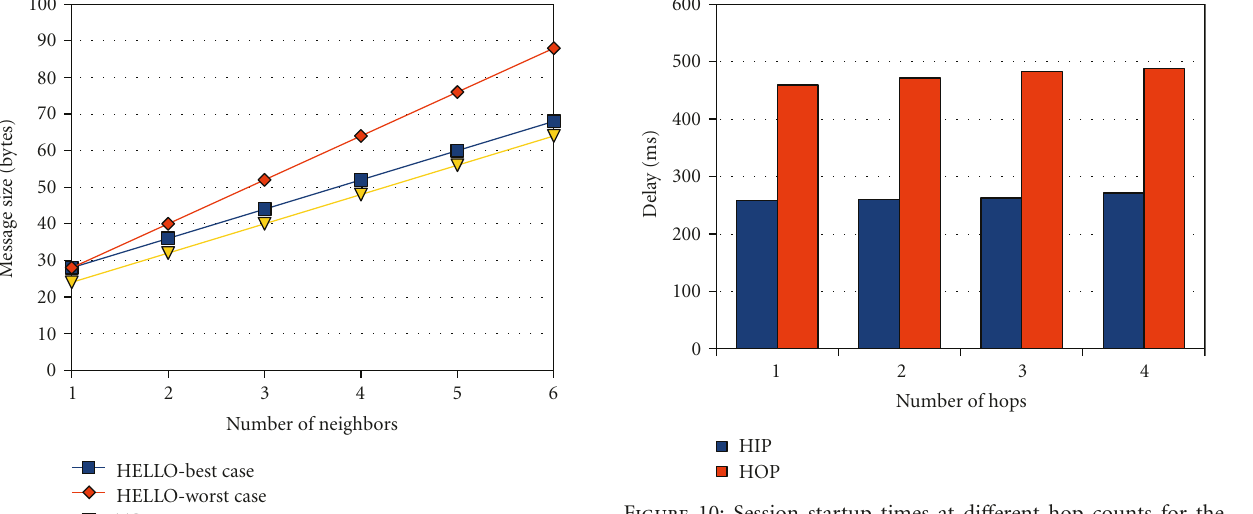
Figure 10: Session startup times at di ff erent hop counts for the default HIP and the proposed A-HIP